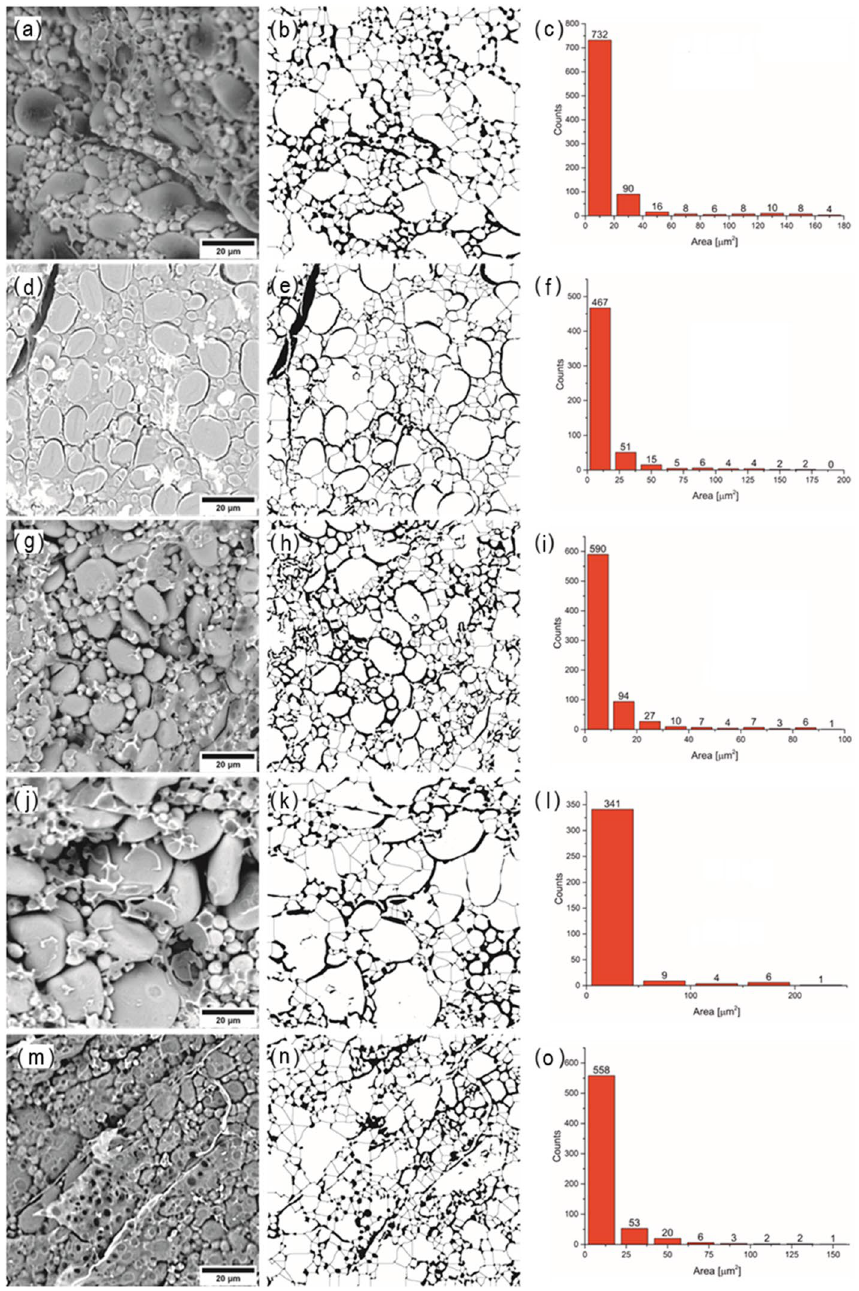
Figure 1. SEM images and corresponding binary maps and histograms of starch of spelt wheat and common wheat: Oberkulmer Rotkorn ( a – c ), Schwabenkorn ( d – f ), Franckenkorn ( g – i ), Zollernspelz ( j – l ), Bombona ( m – o